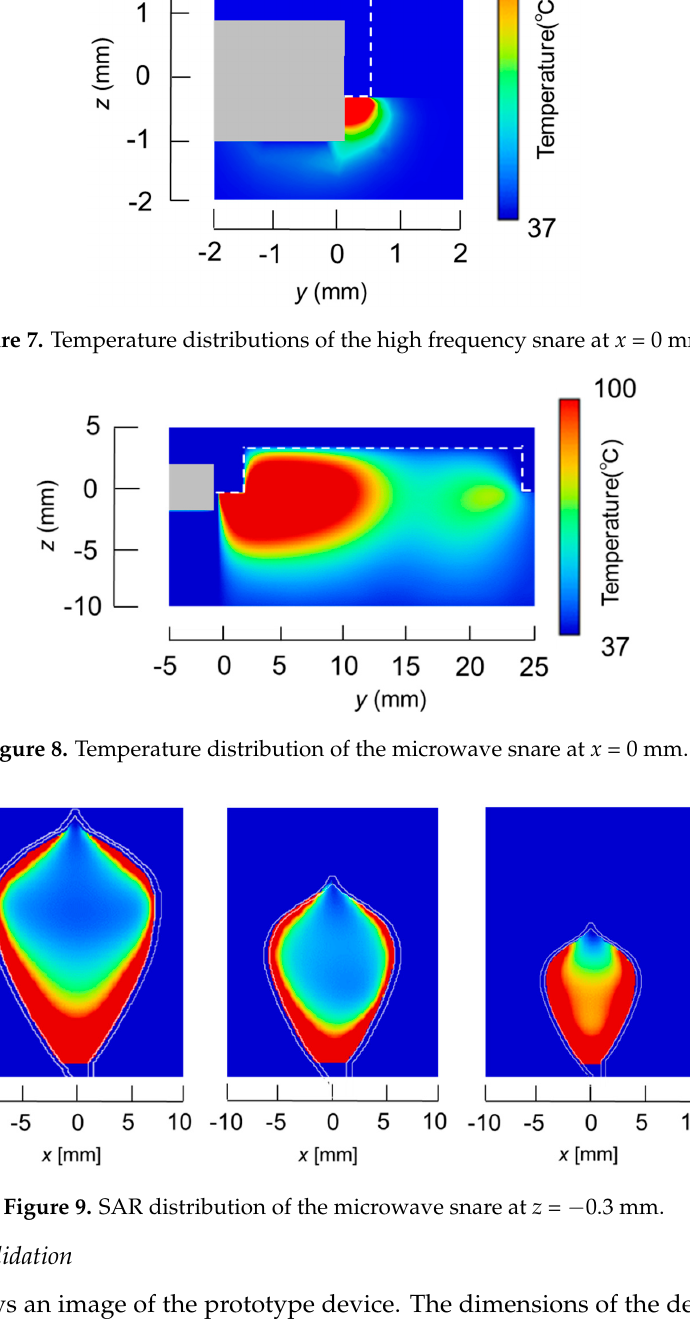
Figure 9. SAR distribution of the microwave snare at z = − 0.3 mm.